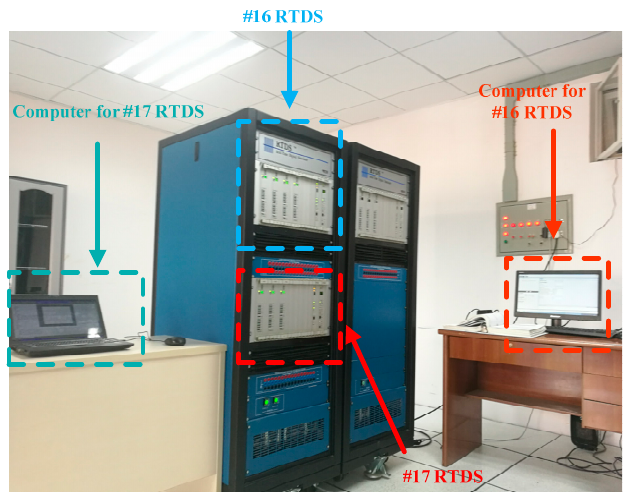
Figure 9. Experimental platform of the HIL test.